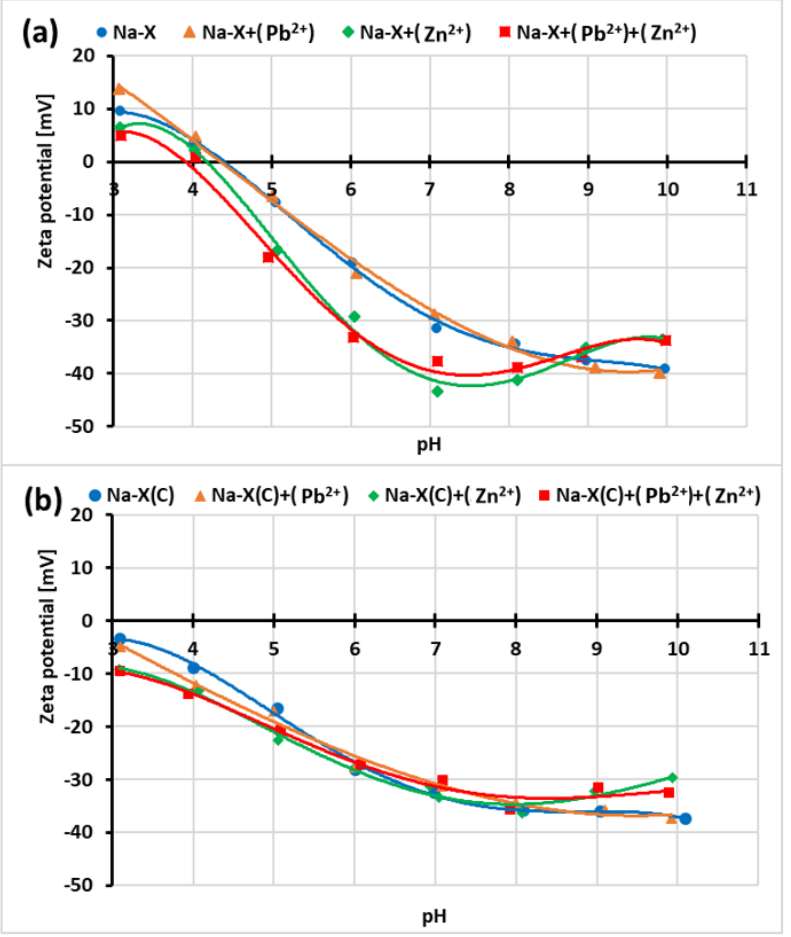
Figure 11. Zeta potential vs. solution pH of Na-X ( a ) and Na-X(C) ( b ) particles with and without one or two heavy metal ions.